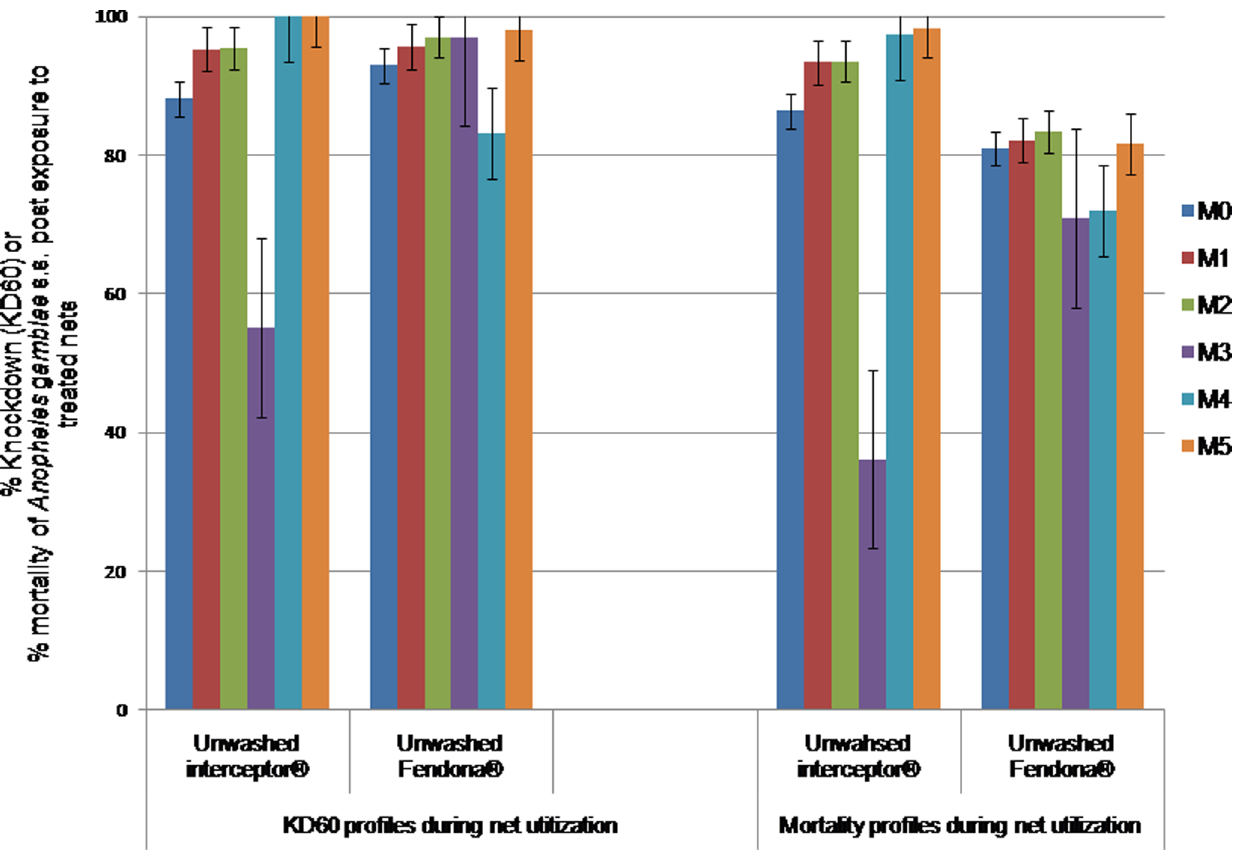
Figure 2. Knockdown and mortality rates of susceptible Anopheles gambiae s.s. post contact with community used Alpha- cypermethrin long lasting nets. M0, M1, M2, M3, M4, M5: month 0, month 1, month 2, month 3, month 4, month 5; KD60: knockdown rate of mosquitoes 60 minutes post contact to treated material. KD60 and mortality rates for interceptor nets remained very during the 5 month trial except on month 3when tested nets were found very dirty. With Fendona SC long lasting treated nets, the KD60 and the mortality rates were slightly but significantly lower than those recorded with Interceptor nets (p , 0.05).